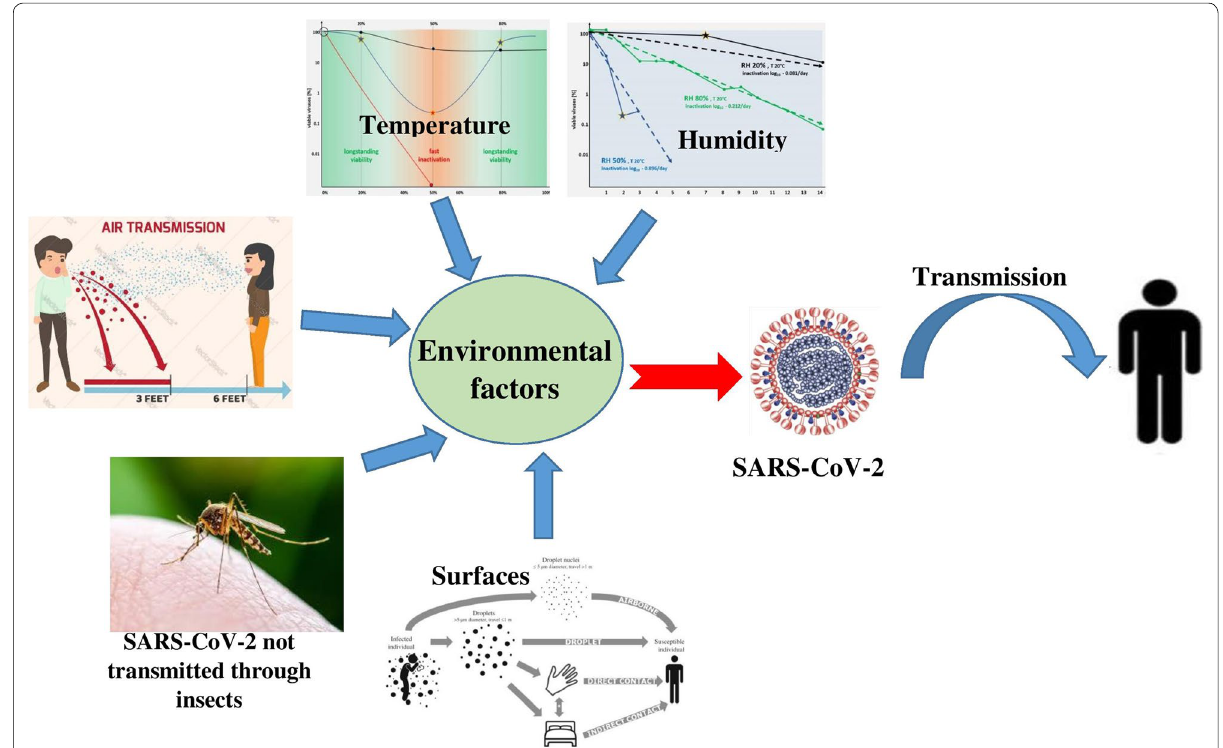
Fig. 1 Environmental factors and transmission of